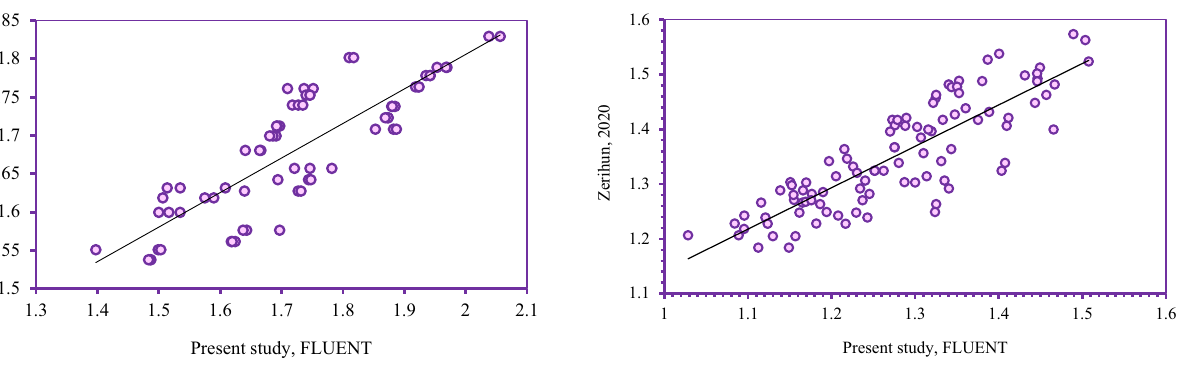
Fig. 20 Comparison of the present numerical simulations results